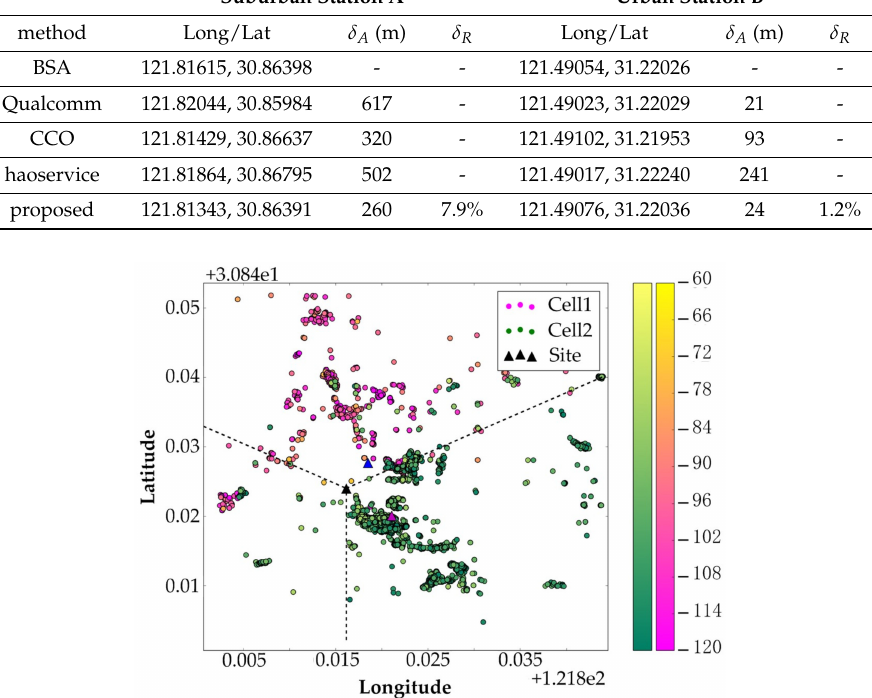
Figure 10. Comparison of BS location estimation for Bi-sector